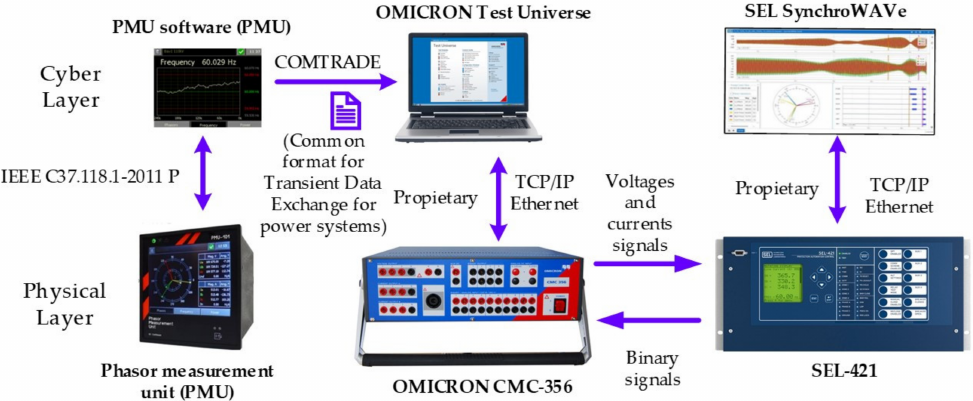
Figure 29. General representation of the cyber-physical approach used in this paper.